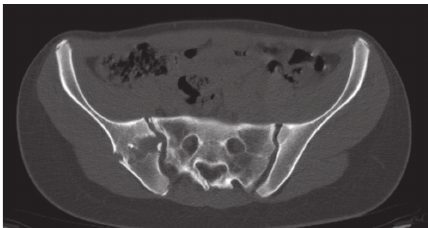
Figure 2: Computed tomography shows erosions of the right ilium, involving the SI joint.